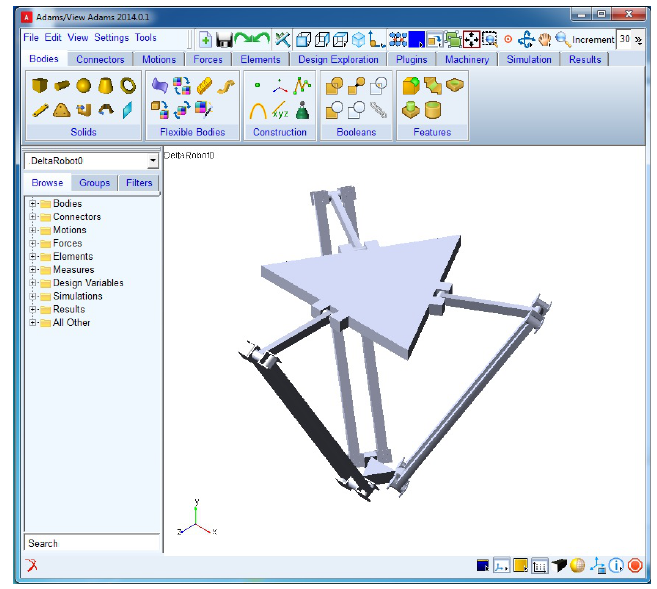
Figure 7. Image of the simulated Flexible Delta Robot in